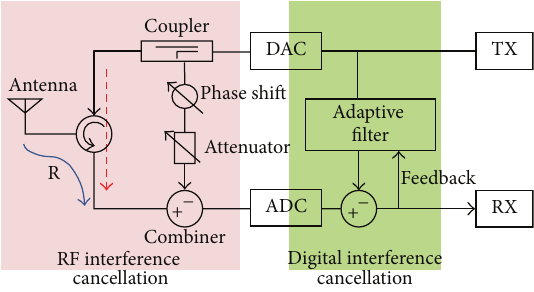
Figure 10: Block diagram of the proposed system in practice.